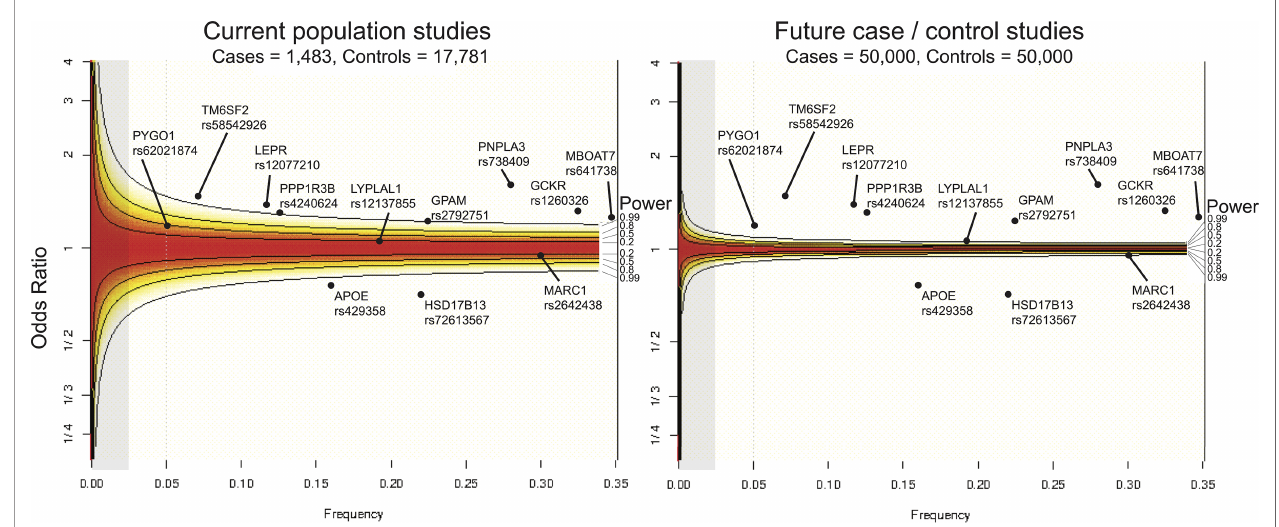
FIGURE 3 | Current state of statistical power to detect genetic associations with NAFLD. Statistical power across odds ratios per allele frequencies computed with a type 1 error rate set at a =0.05 shown for current sample size of NAFLD population studies (left) and for an idealized future NAFLD case/control study (right). Power for frequencies and odds ratios regions are shaded from red to white, in which red indicates regions where statistical power is not suf fi cient to detect an association, and white areas are within the detection limit. Gray areas highlight the section of the power curve for associating rare genetic variants (MAF < 0.025). Associated loci are overlaid according to their effect size and minor allele frequencies. For example, PNPLA3 rs62021874, which has been robusted associated with NAFLD across several studies, is well within the detectable region given its minor allele frequency of 0.28 and odds ratio of 1.8, whereas PYGO1 (frequency = 0.05, odds ratio = 1.3), which has been associated in a single study, is nominally powered to detect an association given the current sample size of NAFLD population studies (56, 82, 85,